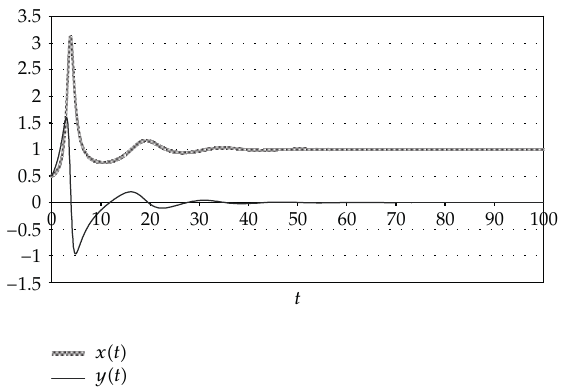
Figure 11: x (cid:2) 0 (cid:3) (cid:6) 0.5, y (cid:2) 0 (cid:3) (cid:6) 0.5, a (cid:6) 0.1, b (cid:6) 0.4, alpha (cid:6) 1.0.